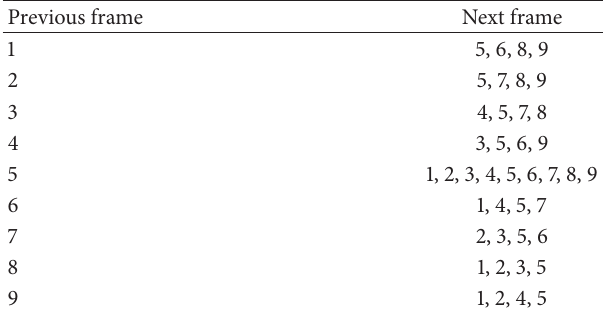
Table 1: Corresponding indexes in the previous frame and the next